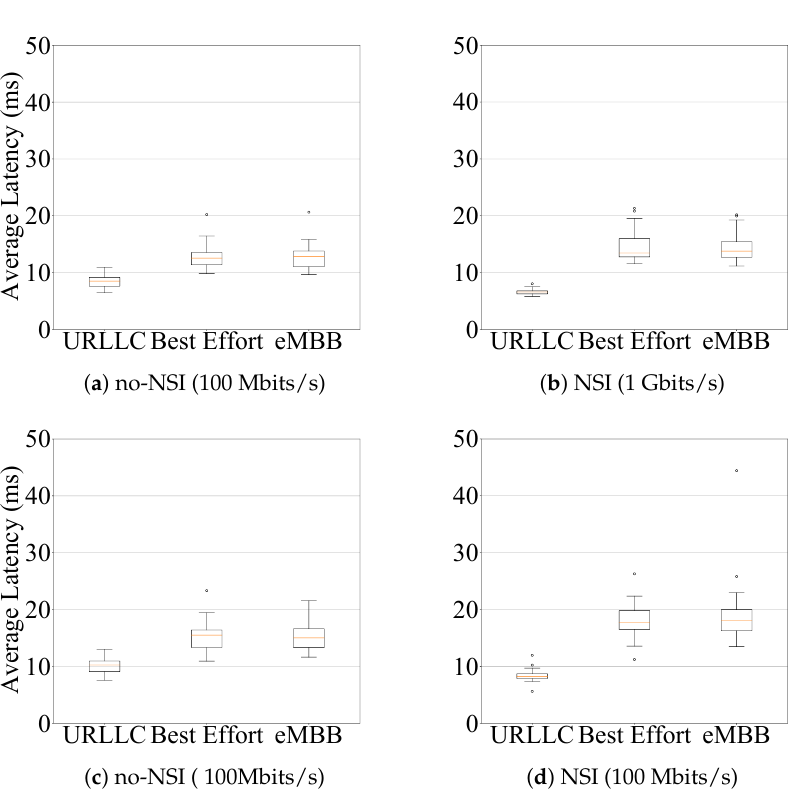
Figure 7. Average